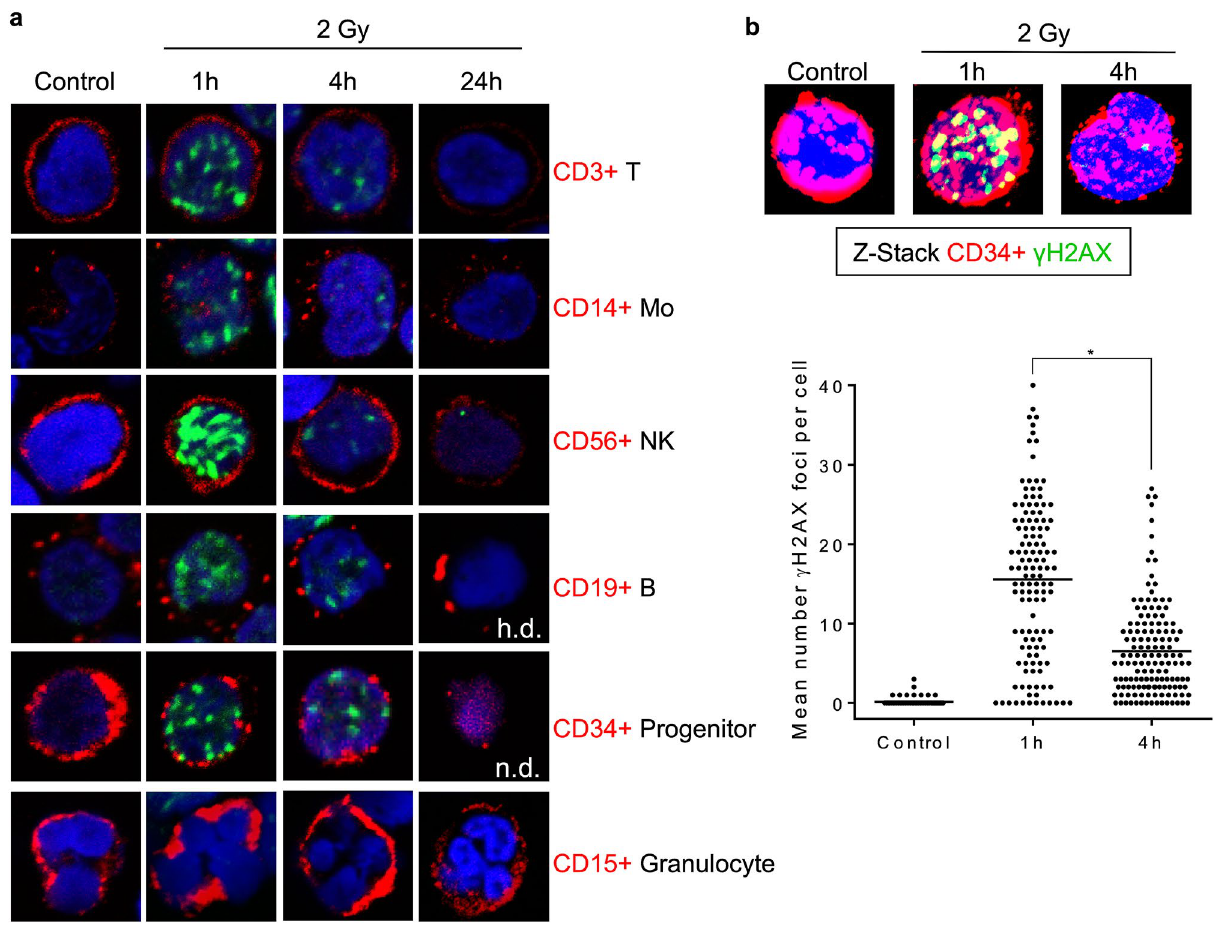
Figure 3. Staining of γH2AX (green) and CD surface markers (red) of different blood cell types purified from buffy coat. ( a ) Representative pictures of unirradiated cells (control) and samples 1 and 24 h after 2 Gy IR. A maximum of γH2AX foci accumulate 1 h after exposure to 2 Gy. γH2AX foci disappear 24 h after radiation implicating effective repair of IR-induced DNA double-strand breaks. CD19+ B cells are hardly detectable (h.d.) on the slide 24 h after treatment. Furthermore, no CD34+ progenitor cells could be found on the slide 24 h post-irradiation (n.d. not detectable). Granulocytes, shown in combination with the CD15 marker, did not show any IR-induced formation of γH2AX foci. ( b ) Quantification of γH2AX foci in CD34+ progenitor cells 1 and 4 h after 2 Gy IR. Representative 3 dimensional pictures (Z-stacks) recorded by the LSM are displayed above the graph. The decrease of γH2AX foci over time indicates an efficient repair of DNA double-strand breaks in CD34+ progenitor cells. n = 3, in total 84–142 cells per box. t-test, * p <